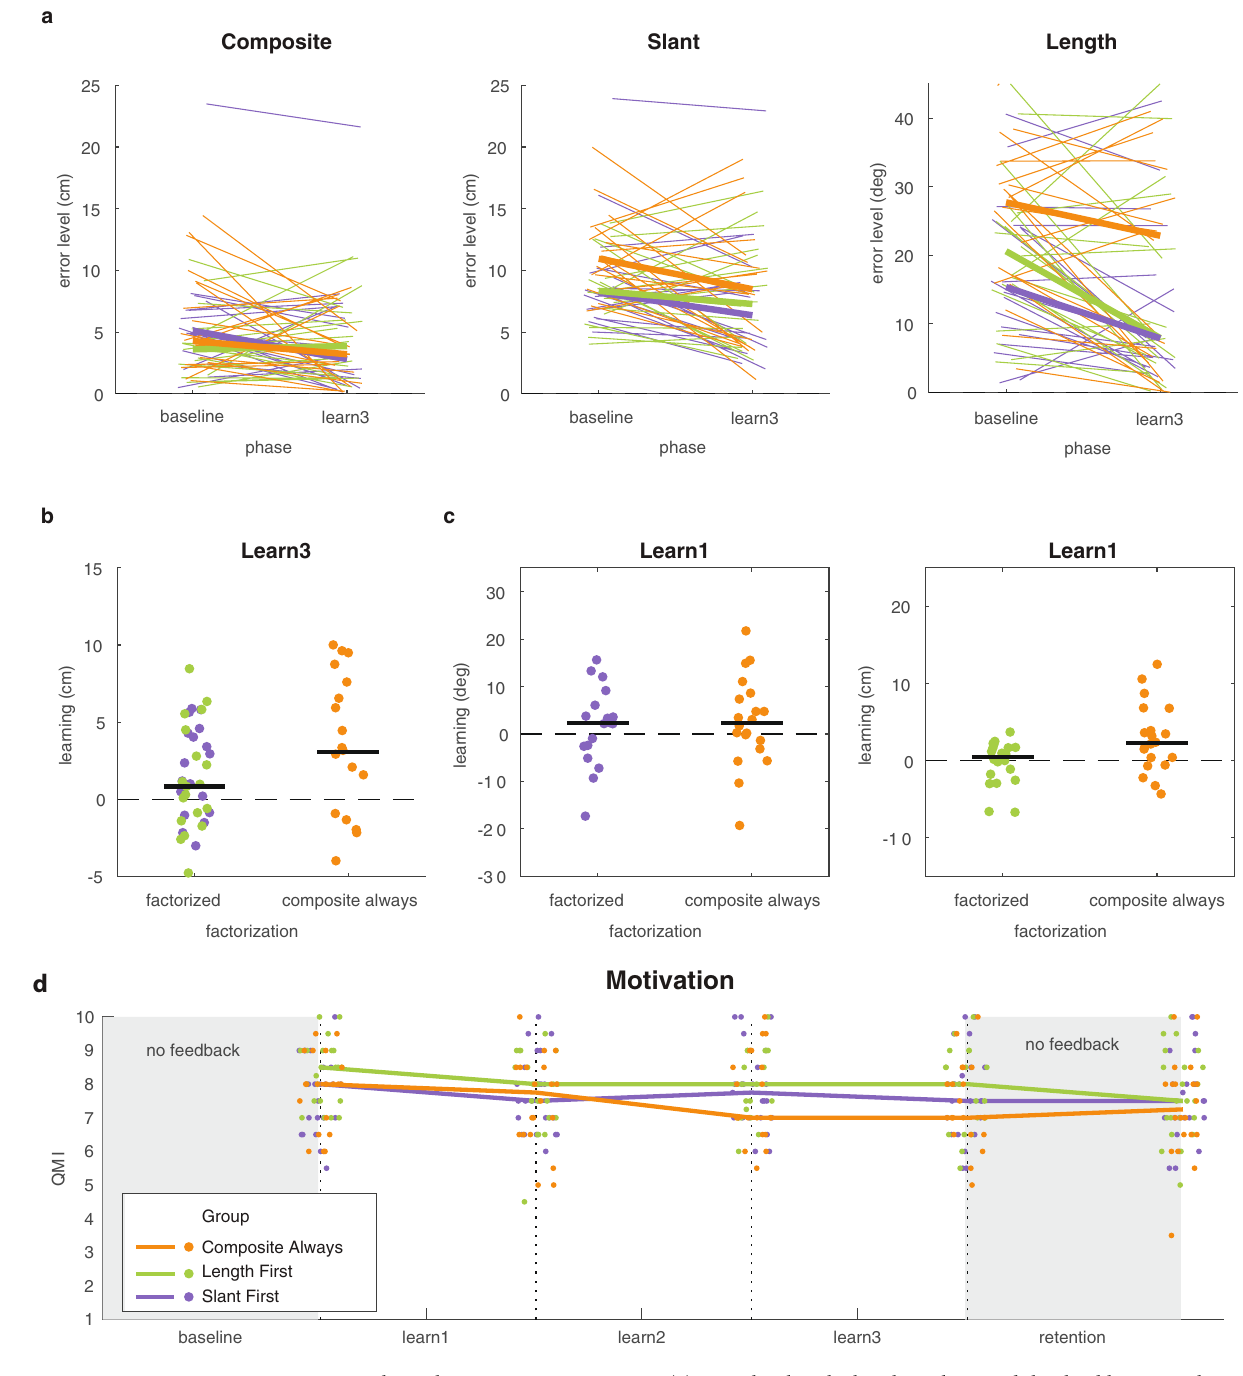
Figure 3. Results on learning in Experiment 1. ( a ) Error level in the baseline phase and the third learning phase for the multidimensional task and the chosen factors. Thin lines represent individual participants whereas the thick lines represent the group median. ( b ) Learning of the multidimensional task in the third learning phase for the groups that received factorized feedback and the group that received composite feedback. ( c ) Learning of slant and length in the first learning phase. Dots represent individual participants and the black lines represents the median across participants. ( d ) Motivation in the three groups as a function of phase number, measured with the Quick Motivation Index that asked about enjoyment and motivation to continue (QMI; van der Kooij et al., 2019). Dots indicate the individual participants; the lines connect the median of each group. For each participant, the horizontal position of the data is the same across all